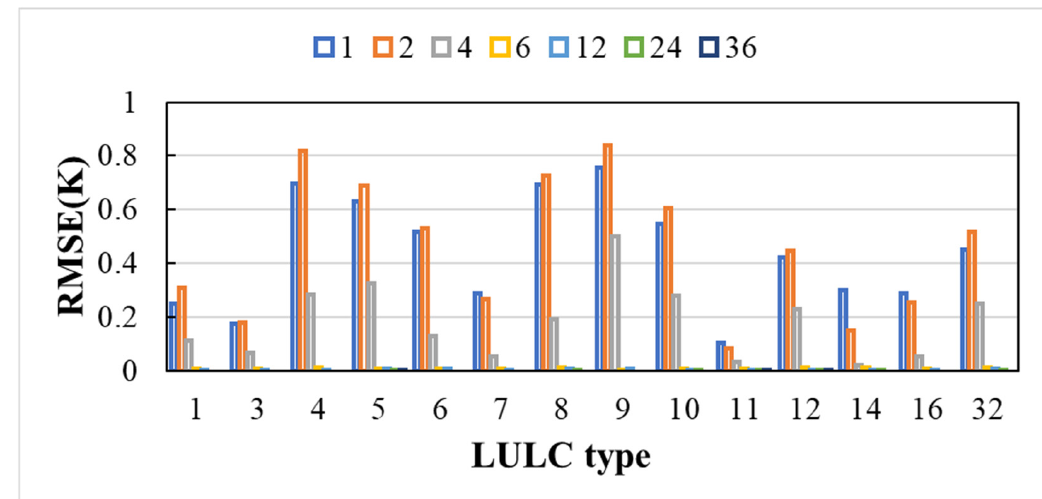
Figure 3. The evaluation results of the spin-up period test group. The numbers on the horizontal axis represent the land cover types: 1: evergreen needleleaf forest, 3: deciduous needleleaf forest, 4: deciduous broadleaf forest, 5: mixed forest, 6: closed shrublands, 7: open shrublands, 8: woody savannas, 9: savanna, 10: grasslands, 11: permanent wetlands, 12: croplands, 14: cropland/natural vegetation mosaic, 16: barren or sparsely vegetated, 32: high-density residential. The different colors of the bars with the sign of 1, 2, 4, 6, 12, 24, and 36 represent the results of the CMFD-1M, CMFD-2M, CMFD-4M, CMFD-6M, CMFD-12M, CMFD-24M, and CMFD-36M.